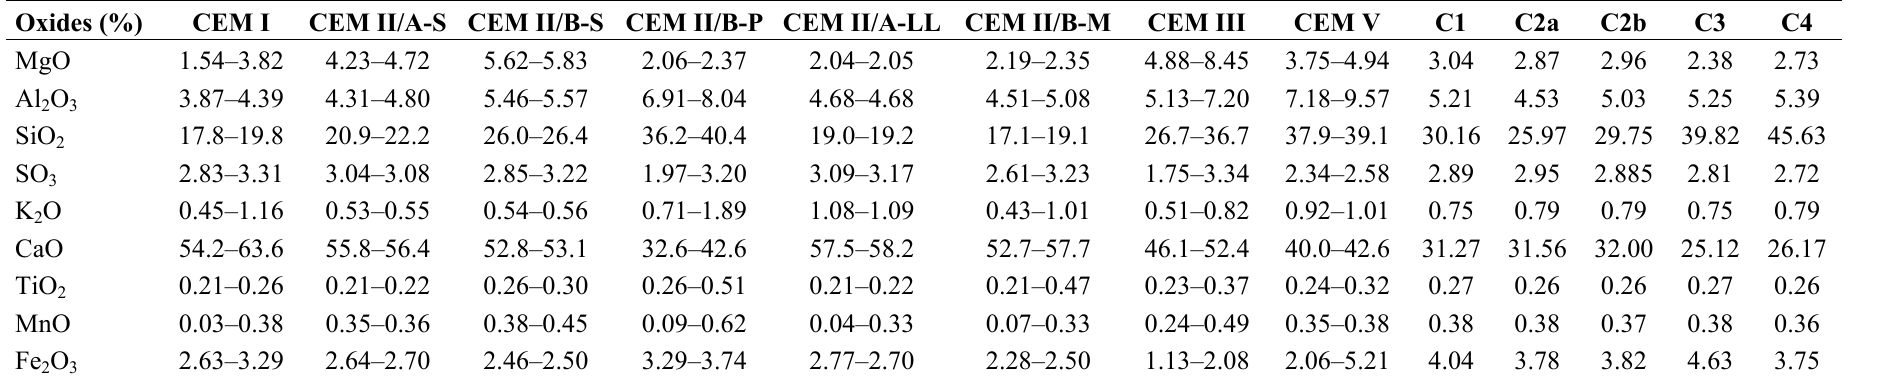
Table 3. The basic chemical composition of studied cements and cement composites.